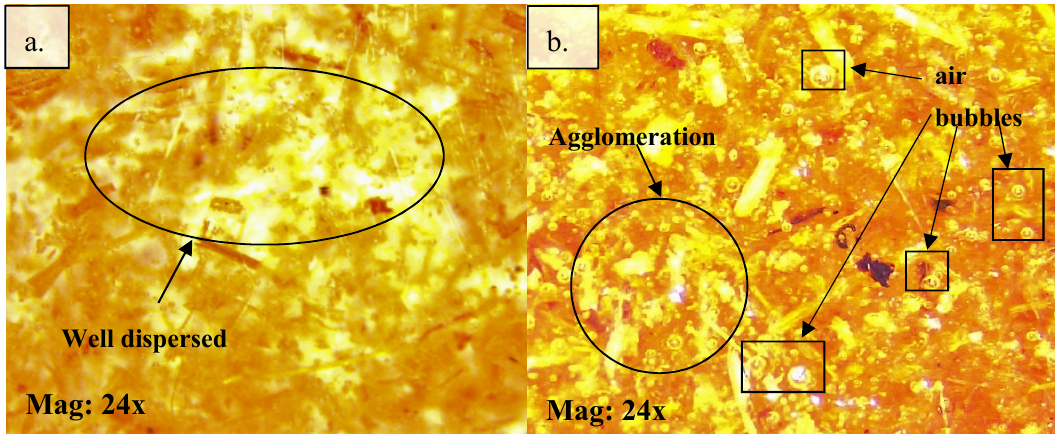
Figure 4. Filler dispersion on fractured test coupons under a stereomicroscope with different filler loadings: ( a ) 2% wt. and ( b ) 5% wt.